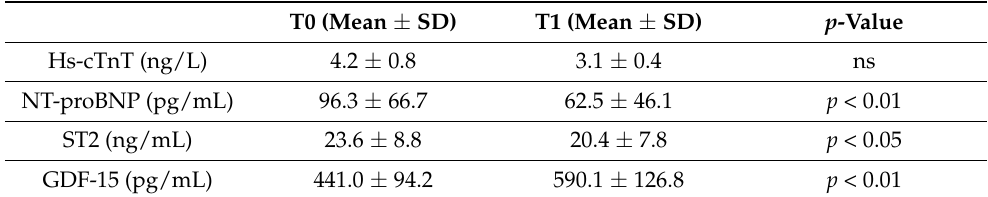
Table 2. Comparison of cardiac biomarker values between T0 and T1. ns = not